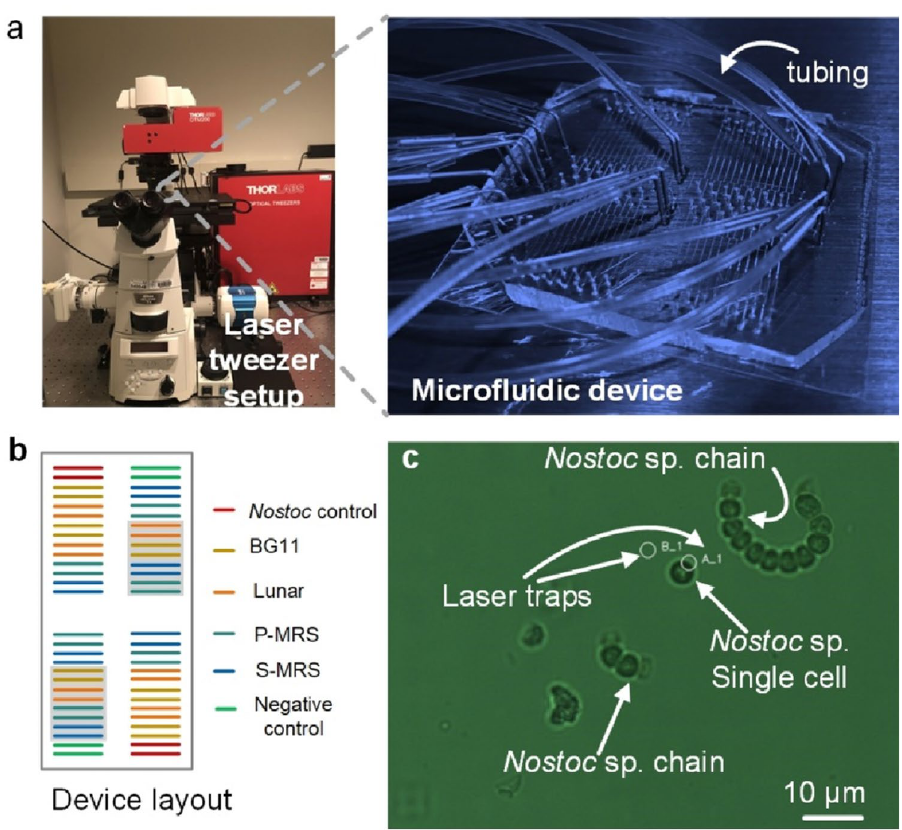
Figure 2. Optofluidic platform overview. ( a ) An optofluidic platform consists of a microscope, laser tweezers and a microfluidic device connected with tubings for high-throughput SC-WGA. ( b ) A schematic diagram of the microfluidic device with 4 identical reaction blocks with 14 reaction lines in each block. The location of samples and controls are shown as color coded. Experimental ground samples are indicated by the grey shades. ( c ) The use of laser tweezers to trap Nostoc CCCryo 231-06 single cells. Laser trap A_1 was turned on and trapped a single cell in the sample suspension. Laser trap B_1 was turned off. S‑MRS sulfatic martian regolith, P‑MRS phyllosilicatic martian